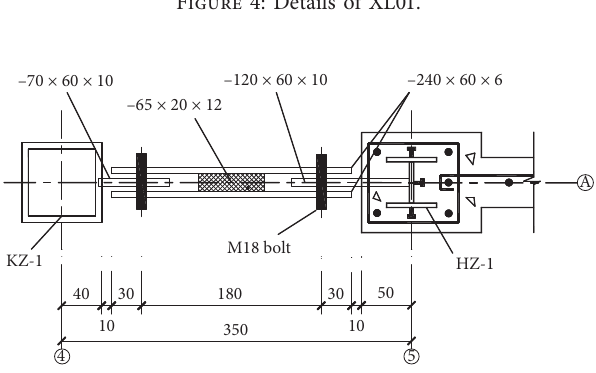
Figure 5: Details of XL02.